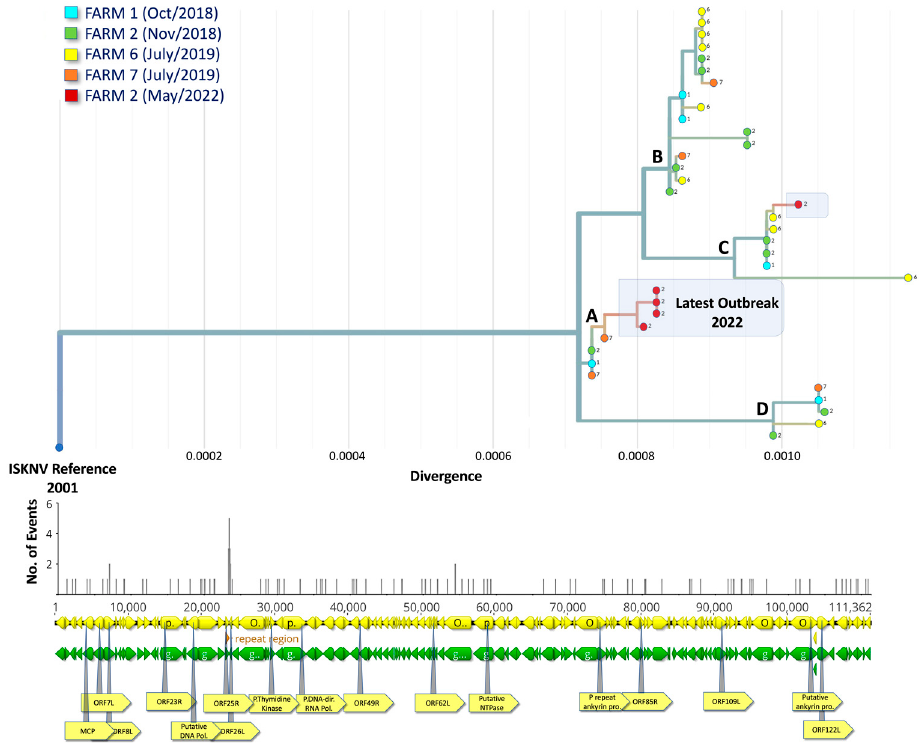
Figure 4. Phylogenetic placement of ISKNV genomes from Ghana and their associated farms. The horizontal axis indicates divergence relevant to the root of the tree. Clades are labelled A–D. The colour of the tips represents the date of sample collection; the number and location of mutational events are shown in the diversity panel below. Sequences from the latest outbreak in 2022 are high- lighted.